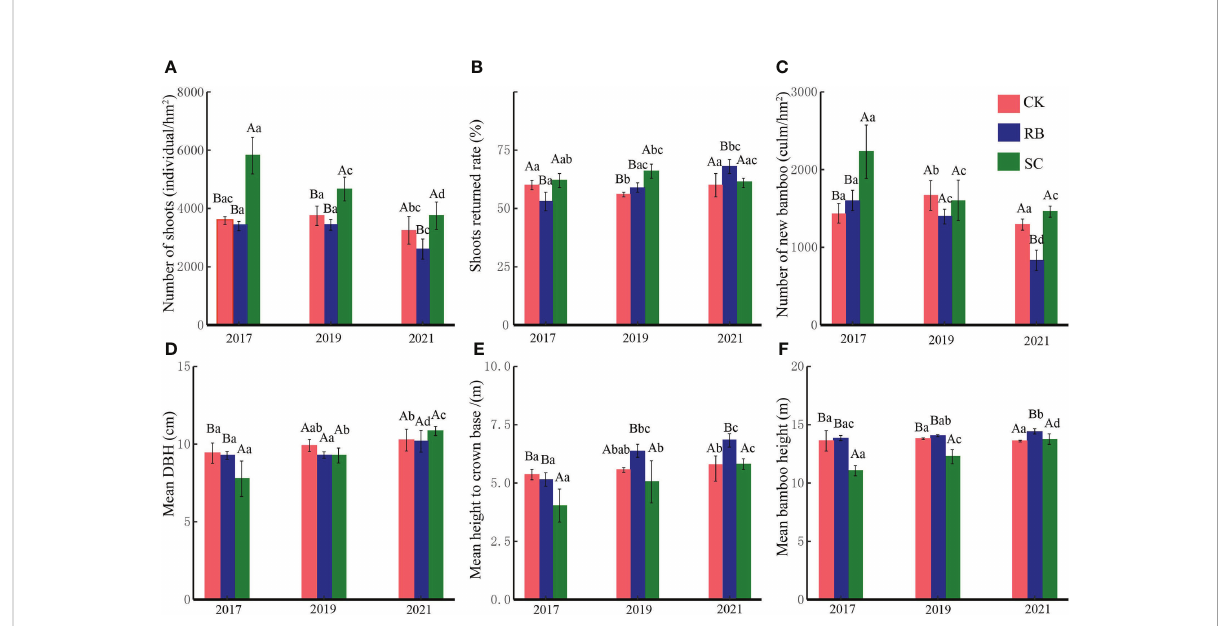
FIGURE 2 Shoot dynamics (A) , number of shoots; (B) , shoots returned rate; (C) , number of new bamboos), and new bamboo characteristics (D) , mean DBH; (E) , mean height to crown base; F , mean bamboo height) in different treatments plot. Different lowercase letters indicate that there are signi fi cant differences in the characteristics of new bamboo in the same treatment plot at different times (ANOVA and LSD test, p < 0.05). Different capital letters indicate that there are signi fi cant differences in the characteristics of new bamboo in different treatments at the same time (ANOVA and LSD test, p < 0.05). Error bars indicate standard deviation (n =